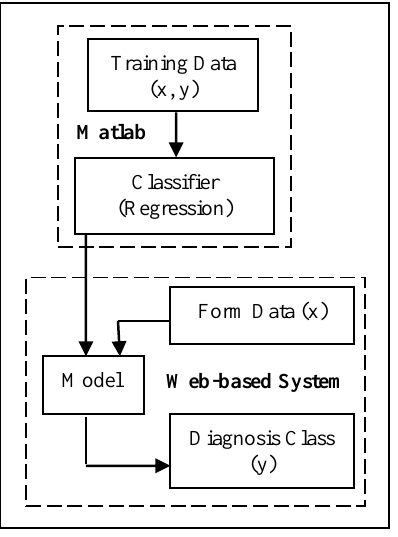
Figure 5. Accessing classifier via web